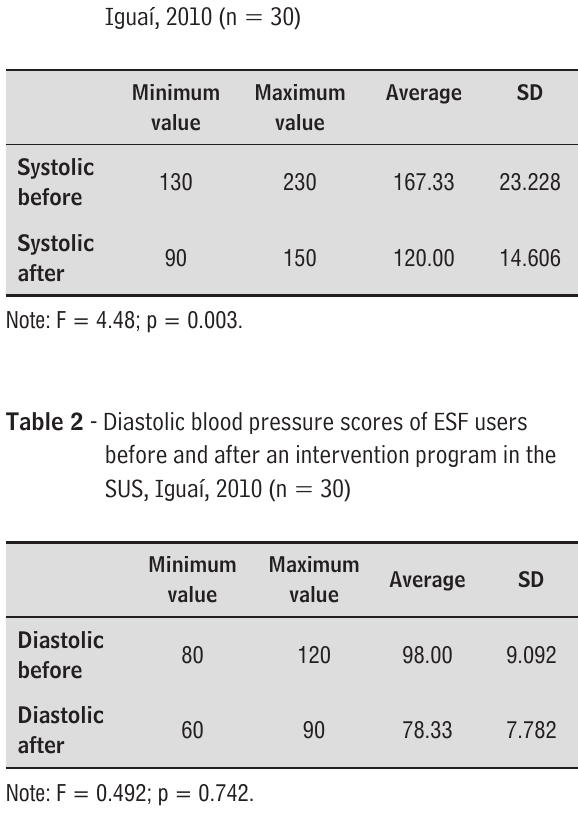
Table 1 - Systolic blood pressure scores of ESF users before and after an intervention program in SUS, Iguaí, 2010 (n = 30)